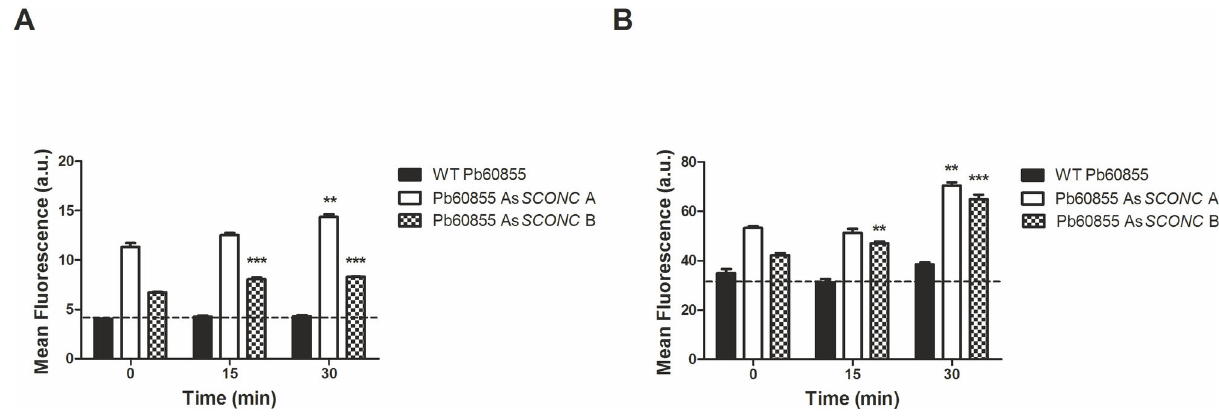
Figure 6. As SCONC transformants present high intracellular levels of reactive oxygen species. ( A ) FACS measurements of superoxide anions using the probe dihydroethidium (DHE) in wild-type strain Pb60855, Pb60855 As SCONC A and Pb60855 As SCONC B, cultured at 37°C in MMvM without inorganic sulfur compounds supplementation (MMvM +Cys/-SO 42- ) at time 0 and 15 and 30 min after a punch with inorganic sulfur compounds. Asterisks represent significant differences between 0 min and either 15 min or 30 min for each strain (**p<0.01; ***p<0.001); ( B ) FACS measurements of H O using dihydrorhodamine 123 (DHR) in wild- 2 2 type strain Pb60855, Pb60855 As SCONC A and Pb60855 As SCONC B, cultured at 37°C in MMvM without inorganic sulfur compounds supplementation (MMvM +Cys/-SO 42- ) at time 0 and 15 and 30 min after a pulse with inorganic sulfur compounds [MgSO .7H O (2 mM) and (NH ) SO (15 mM)]. Asterisks represent significant differences between 0 min and either 15 min or 30 4 2 4 2 4 min for each strain (**p<0.01; ***p<0.001). Bar graphs indicate mean and standard deviation of fluorescence/cell (arbitrary units) measured in 1x10 5 cells per sample in three independent experiments. Statistical analysis was performed comparing 15 and 30 min to time 0 for each